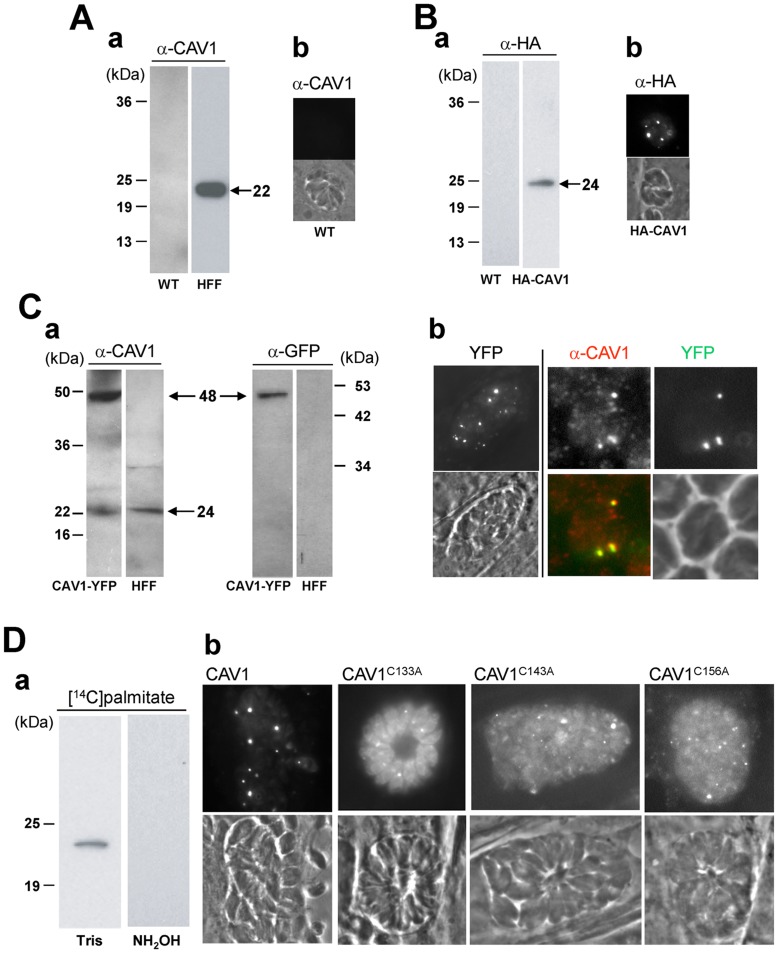
Expression and localization of recombinant CAV1 in Toxoplasma.(A) Panel a: Immunoblots of homogenates from wild-type T. gondii (left lane) and HFF (right lane) revealed with anti-CAV1 antibodies (α-CAV1), showing no expression of CAV1 by the parasites as confirmed by IFA in Panel b. (B) Expression of HA-CAV1 by transgenic parasites. Immunoblots of homogenates from wild-type T. gondii (left lane) and Toxoplasma transiently expressing HA-CAV1 for 36 h (right lane) revealed with anti-HA (α-HA), showing a band at ∼24-kDa in transgenic parasites. Panel b: Localization of HA-CAV1 in transgenic parasites by IFA showing a fluorescent punctuate pattern in transgenic parasites. (C) Panel a: Expression of CAV1-YFP by transgenic parasites. Immunoblots of homogenates from HFF infected with parasites stably expressing CAV1-YFP (left lanes) and uninfected HFF (right lanes) revealed with antibodies against CAV1 or against GFP (α-GFP) as indicated. The Western blots reveal bands at 48-kDa and 24-kDa corresponding to CAV1-YFP in T. gondii and CAV1 in HFF, respectively. Panel b: Localization of CAV1-YFP in transgenic parasites. Left: Direct fluorescence microscopy assays of CAV1-YFP-expressing parasites showing a vesicular staining. Right: Double immunofluorescence assays (IFA) of CAV1-YFP-expressing parasites using anti-CAV1 and anti-GFP antibodies illustrating structures co-labeled with the two antibodies. (D) Post-translational palmityolation of CAV1 in transgenic parasites. Panel b: Infected HFF with HA-CAV1-expressing parasites were labeled with [14C]palmitate for 6 h before isolation of the parasites. Toxoplasma homogenates were then immunoprecipitated with anti-HA antibodies and resolved in SDS gels containing either Tris or Tris/hydroxylamine for 12 h before analysis for fluorography. The gels shown are representative of one on two separate experiments, and revealed the association of radioactive palmitate with HA-CAV1. Panel b: Localization of mutant CAV1-YFP lacking palmitoylation residues in transgenic parasites. Direct fluorescence assays of intracellular Toxoplasma expressing CAV1C133A-YFP (CAV1C133A), CAV1C143A-YFP (CAV1C143A) or CAV1C156A-YFP (CAV1C156A) showing more cytosolic staining for YFP compared to Toxoplasma expressing wild-type CAV1.